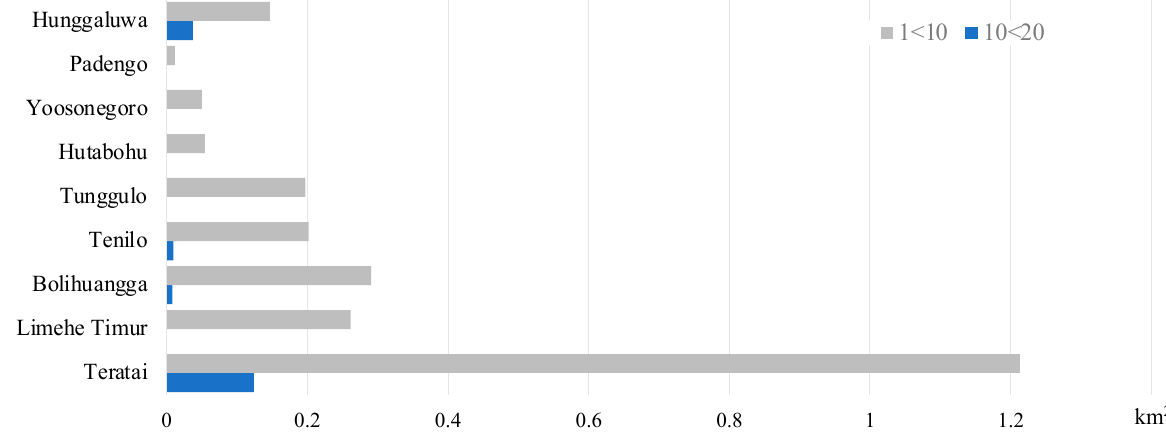
Figure 9. Area identified with surface water occurrences by villages (1984–2021). The extracted SWOs < 30 were further overlapped with the imagery of 23 May 1978 and 7 December 2022 (Figure 10). Although a higher SWOs 20 < 30 was observed in the lake water area, a lower SWO was observed in inland areas (Figure 10b). The lower SWOs <10 in inland areas were largely found in floodwater-detected areas (Figure